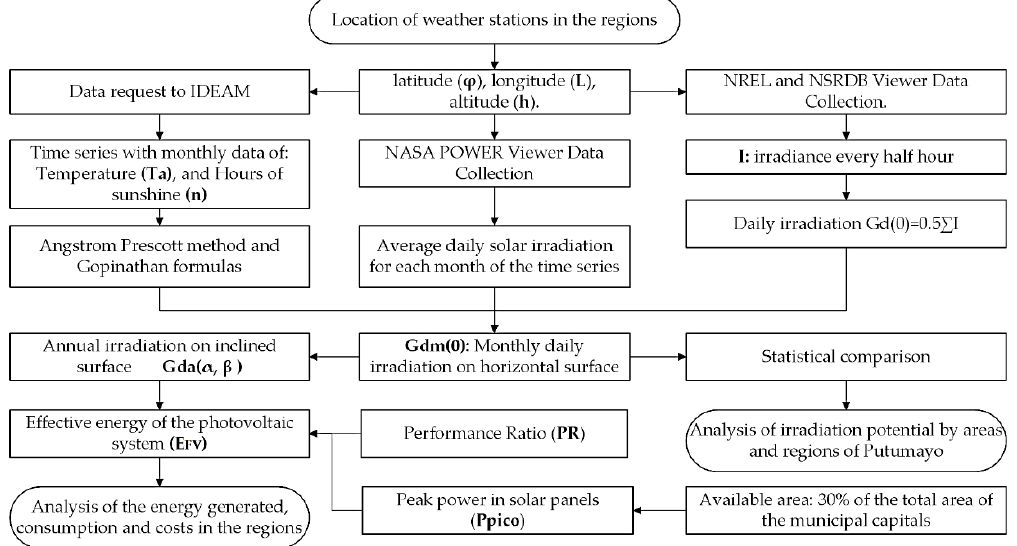
Figure 1. Location of the department of Putumayo and the Andean, Andean-Amazon, and Amazon regions.